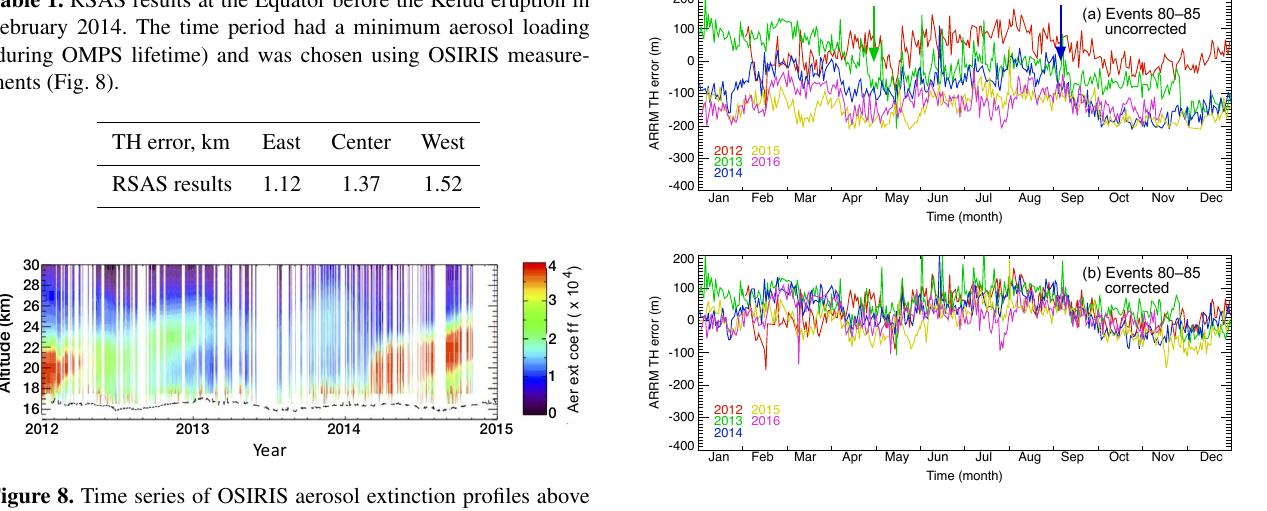
Figure 8. Time series of OSIRIS aerosol extinction profiles above the tropopause (dashed line). The large aerosol extinction coeffi- cients in 2012 are due to the June 2011 Nabro eruption in Eritrea. The aerosols at 20km reached a minimum value (during OMPS life- time) just before the eruption of the Kelud volcano on 14 Febru- ary 2014.